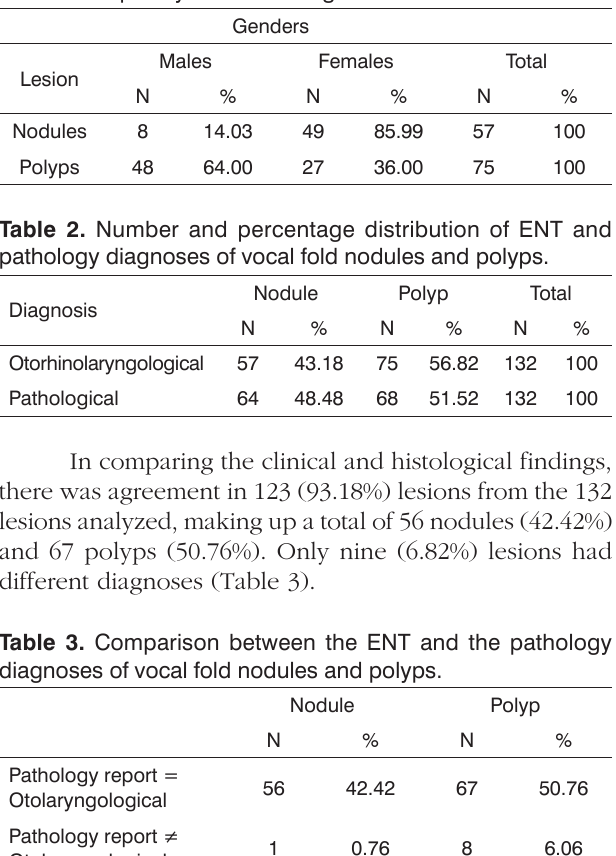
Table 1. Number and percentage distributions of polyps and nodules frequency in relation to gender.